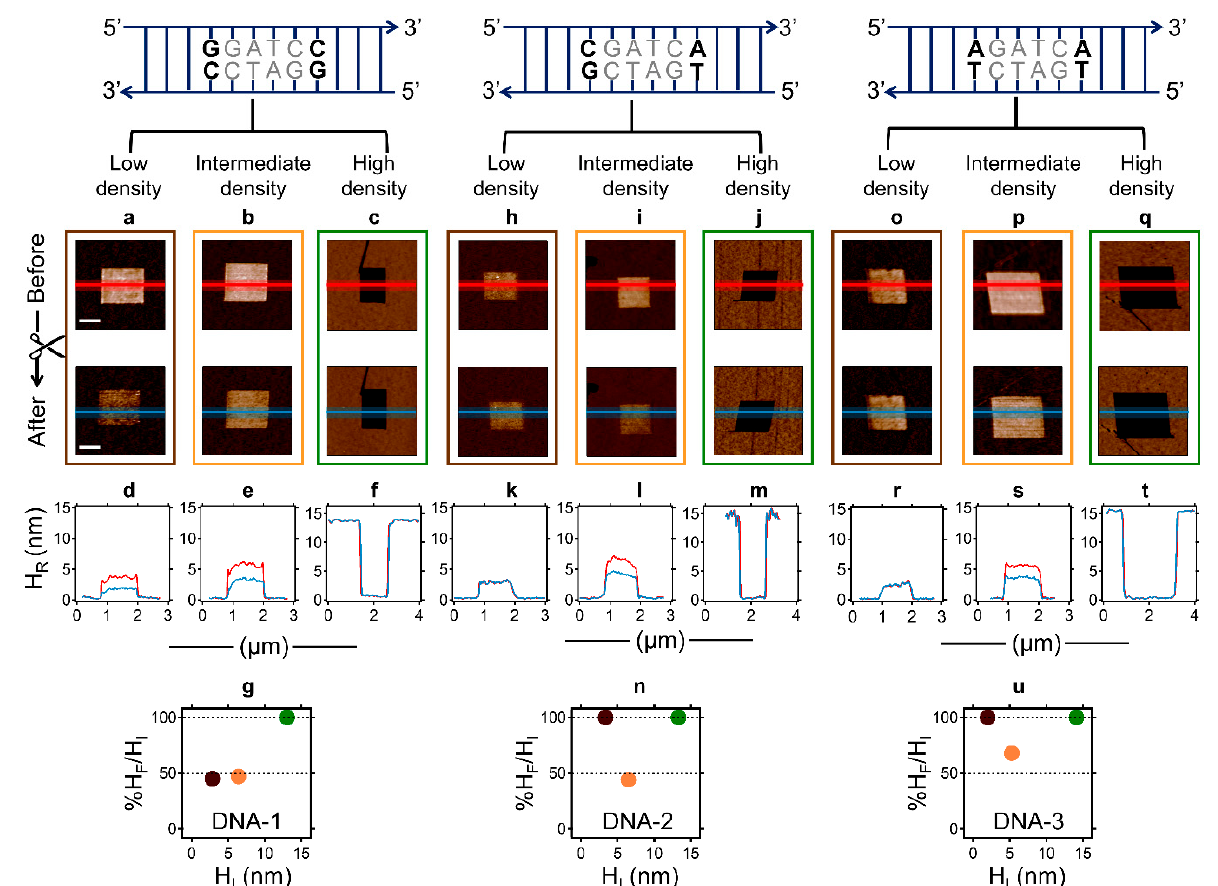
Figure 3. Analysis of noncanonical BamHI action in LCDMs as a function of DNA density and sequence. AFM micrographs in ( a – c , h – j , o – q ) display LCDMs before (top, red line) and after (below, blue line) BamHI action, for DNA-1, DNA-2, and DNA-3, respectively (see restriction sites above; shared sequence in grey). In each AFM image, the darker area is an ethylene-glycol-terminated alkylthiol monolayer while the coloured line corresponds to the height profiles in ( d – f , k – m , r – t ), respectively. Representative LCDMs are shown for three DNA densities: low (brown frames in ( a , h , o )), intermediate (orange frames in ( b , i , p )), and high (green frames in ( c , j , q )). Plots in ( g , n , u ) show the percentage ratio of the relative LCDM height after BamHI action (H F ) and the initial relative height (H I ), as a function of three representative H I values for DNA-1, DNA-2, and DNA-3, respectively. The values shown are averages from the height profiles in ( d – f , k – m , r – t ), respectively. With DNA-1 ( g ), the average height is reduced by half at low (brown; ( a , d )) and intermediate (orange; ( b , e )) densities while at intermediate densities, a similar behaviour is observed for DNA-2 ( i , l , n ) and DNA-3 ( p , s , u ). The scale bar (shown in white in panel ( a )) in all AFM micrographs is 500